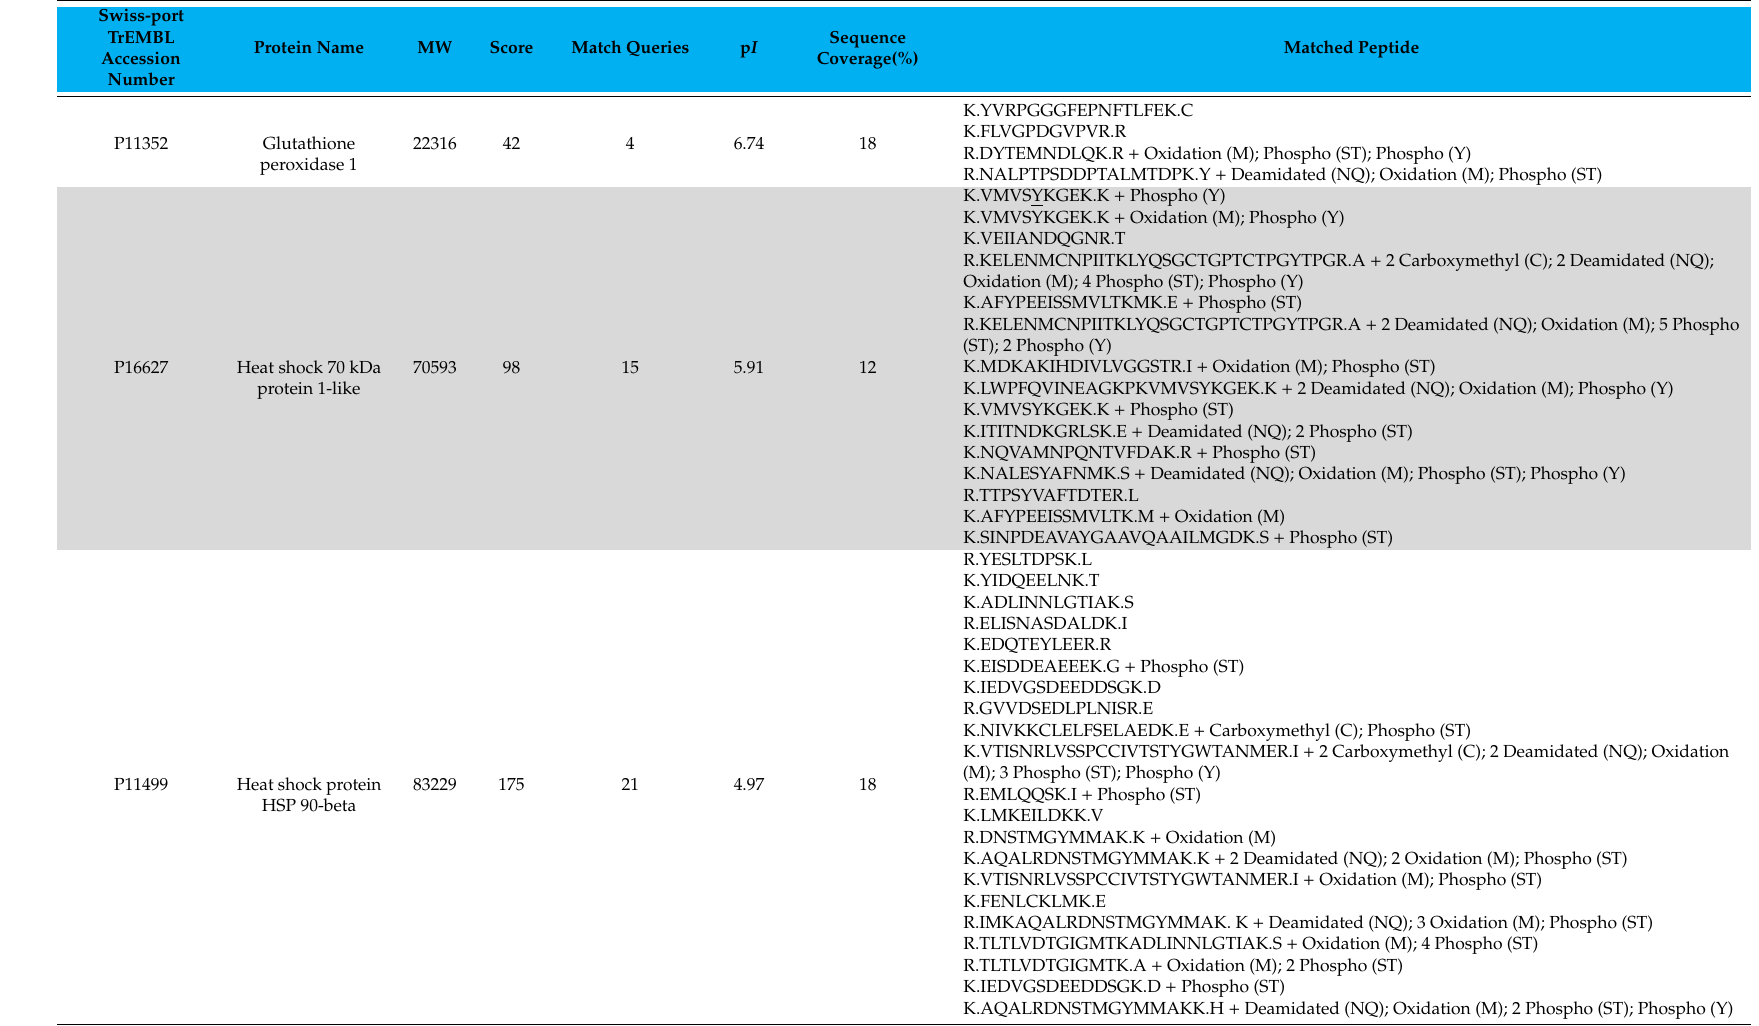
Table 5. Summary of proteins corresponding to